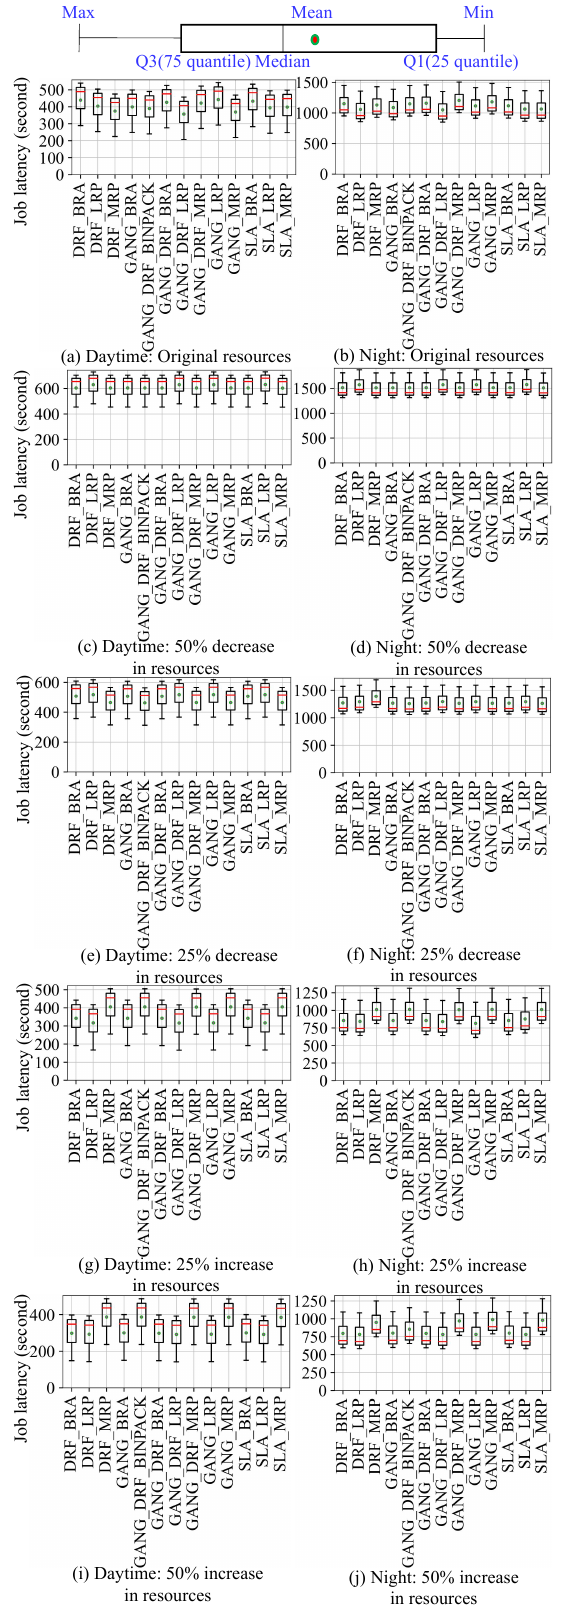
Figure 10. Simulation: JobQueue